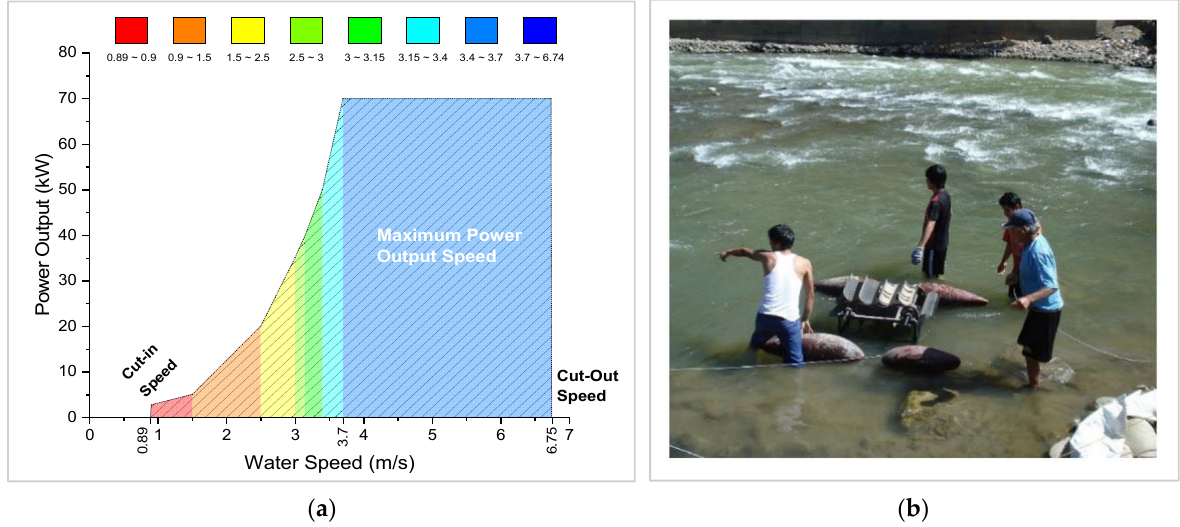
Figure 3. ( a ) Power output vs. water speed curve for a hydrokinetic river turbine. ( b ) Installation of the Schottel hydrokinetic river turbine [49].